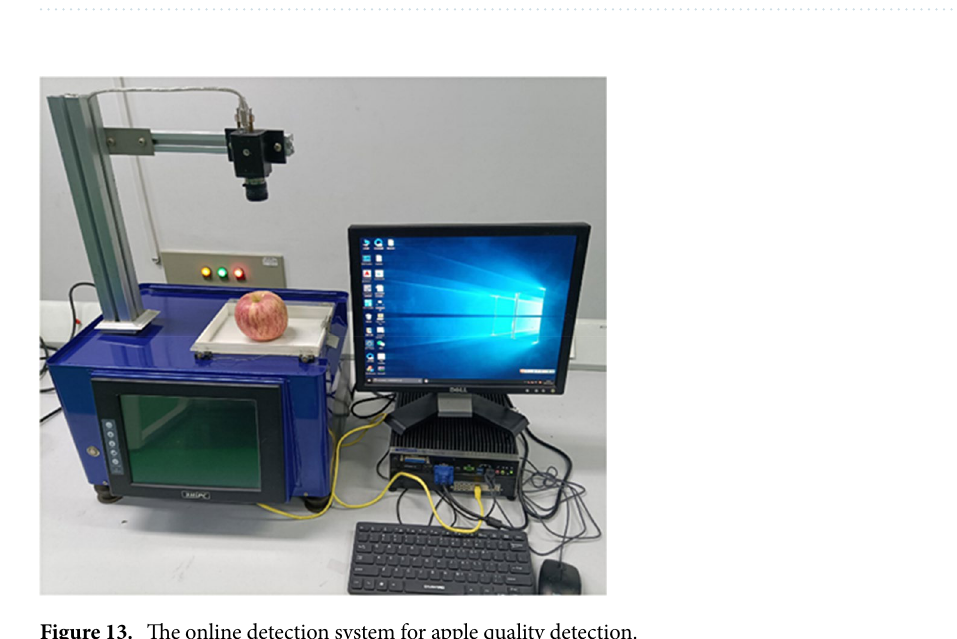
Table 2. Classification results of validation set for traditional method.